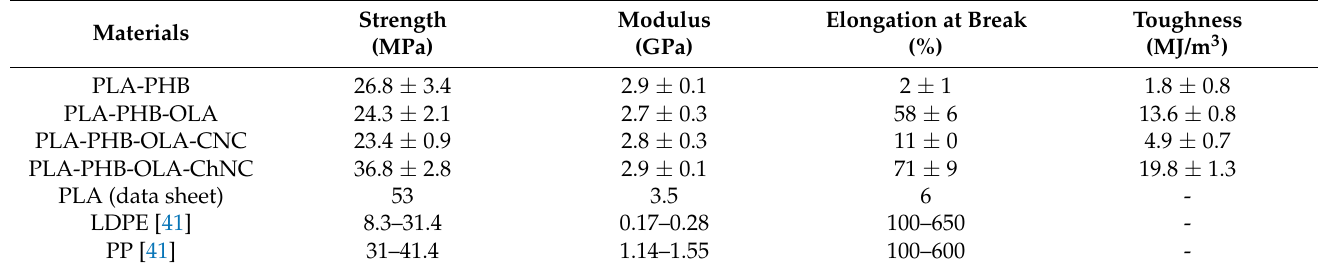
Table 5. Mechanical properties of the blown films tested in the blowing direction compared with PLA, LDPE, and